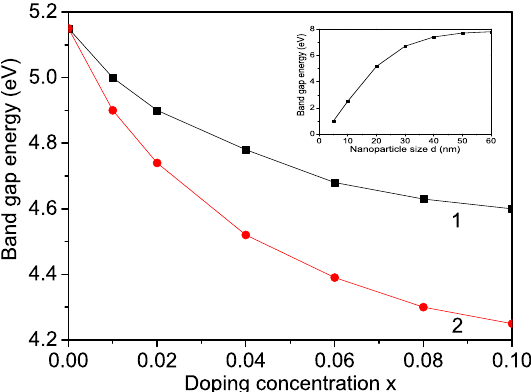
Figure 7. Ion-doping concentration dependence of the band gap energy for a (1) Co and (2) Fe-ion- doped MgO NP for J d = 1.3 J b . Inset: E g ( d ) for pure MgO.